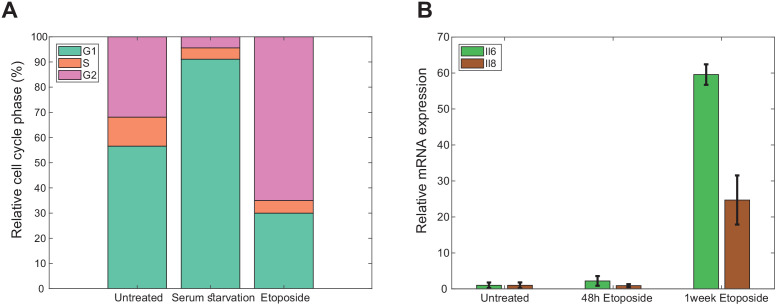
Serum starvation and Etoposide treatments induced quiescence and senescence respectively in WI38 fast cells.(A) Cell cycle analysis of arrest-triggered cell populations. Each stacked bar represents a population that was untreated or treated to trigger entering into a cell cycle arrest state (i.e. serum starvation to induce quiescence, and low dosage of Etoposide to induce senescence) for 48 hr. In each bar, the percentage of cells at different cell cycle phases is shown. The results are averaged over two biological repeats. (B) Relative mRNA expression of senescence markers. mRNA expression of Il6 and Il8 in each sample is normalized to the expression of GAPDH, and presented as fold-change to the averaged expression of untreated samples (n = 2, error bars represent standard errors).